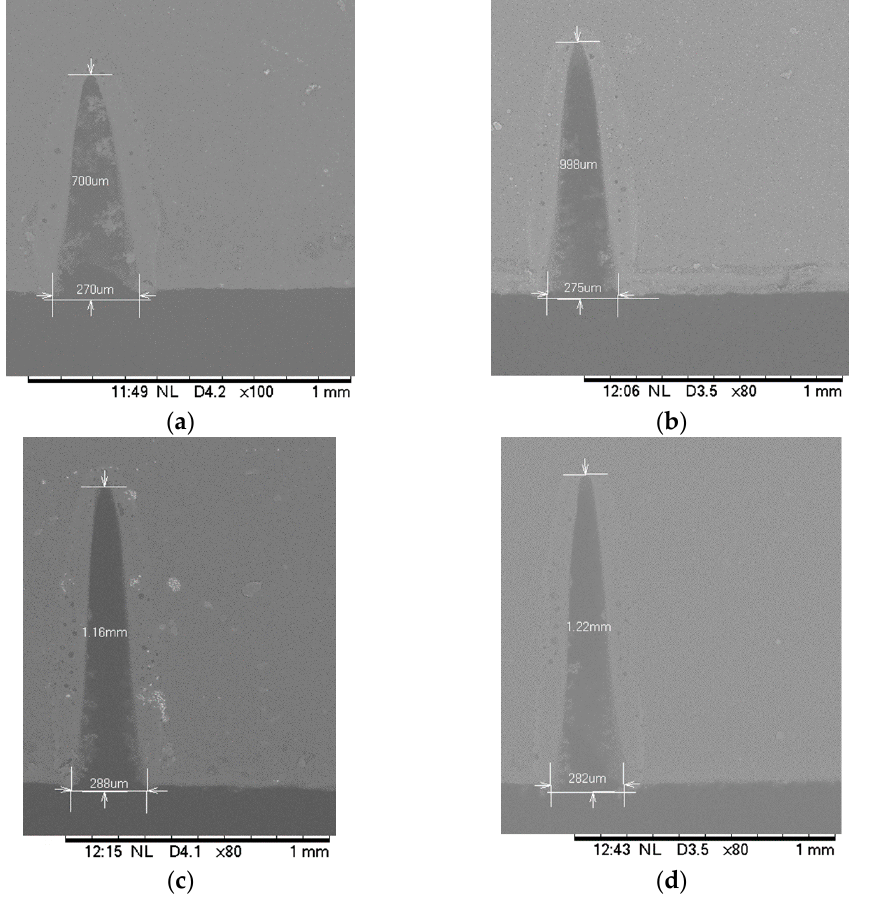
Figure 3. Scanning electron microscope (SEM) images and measurement of CO 2 laser-machined microchannels on PMMA substrate with ( a ) 10 %, ( b ) 20%, ( c ) 30%, and ( d ) 40% of total laser power. The 45W laser engraving machine was set at single pass and 10 mm/s scanning speed. The PMMA substrates were placed at the focal distance of the laser focusing lens.